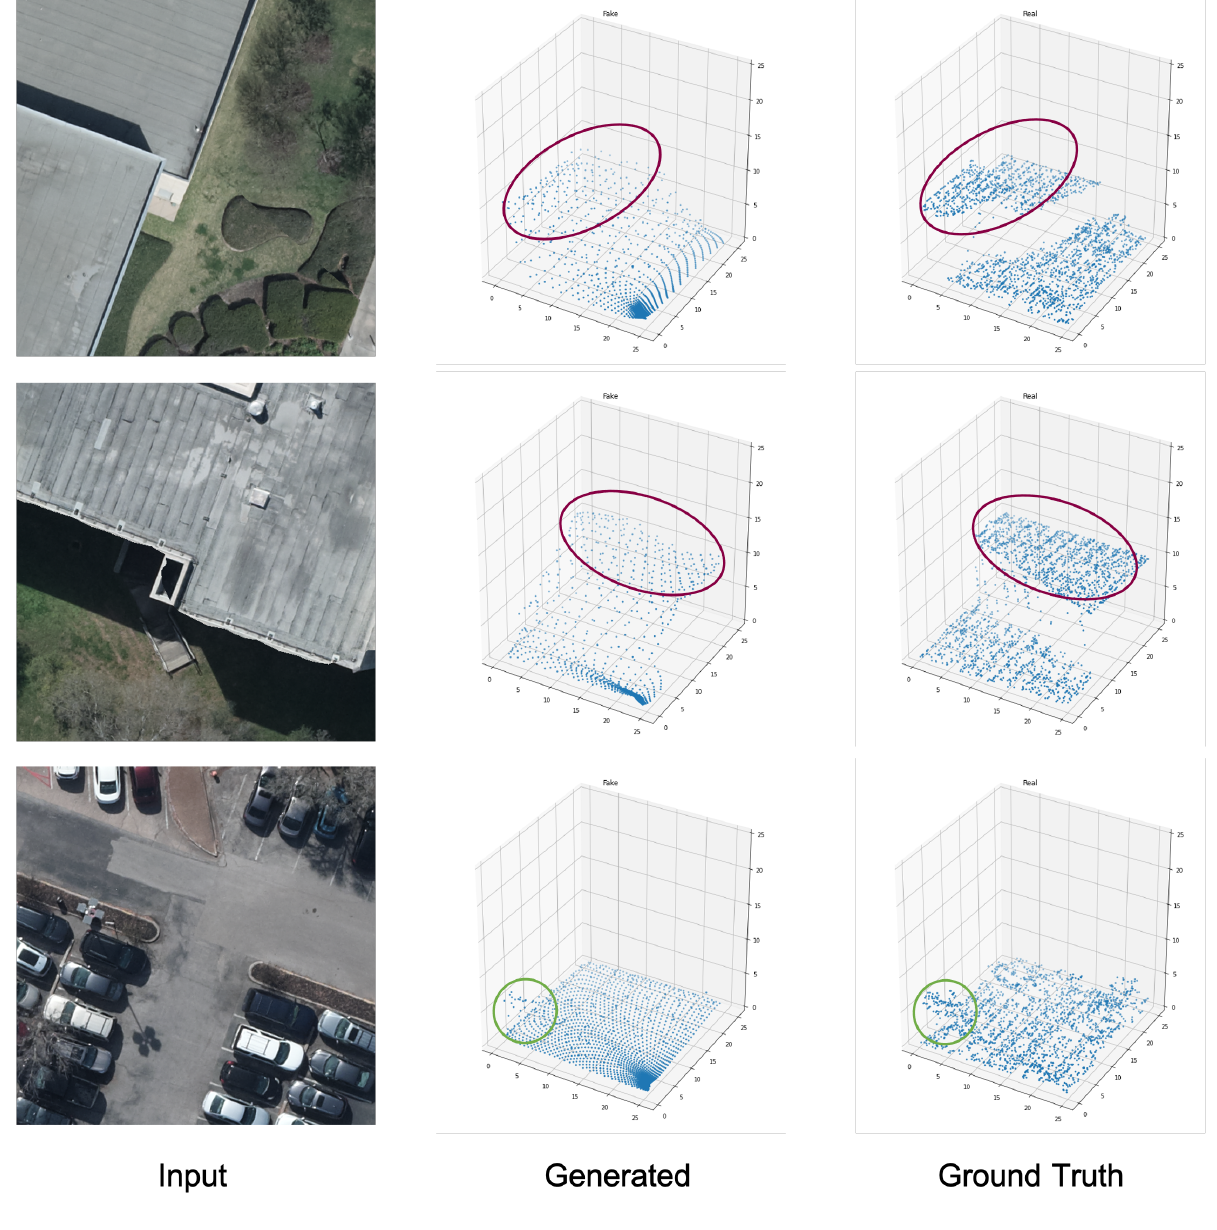
Figure 5. The generated fake point clouds y fake via latent feature z from input image X . The left figures are the input aerial image X , the middle figures are y fake , and the right figure are real (ground truth) point cloud y real